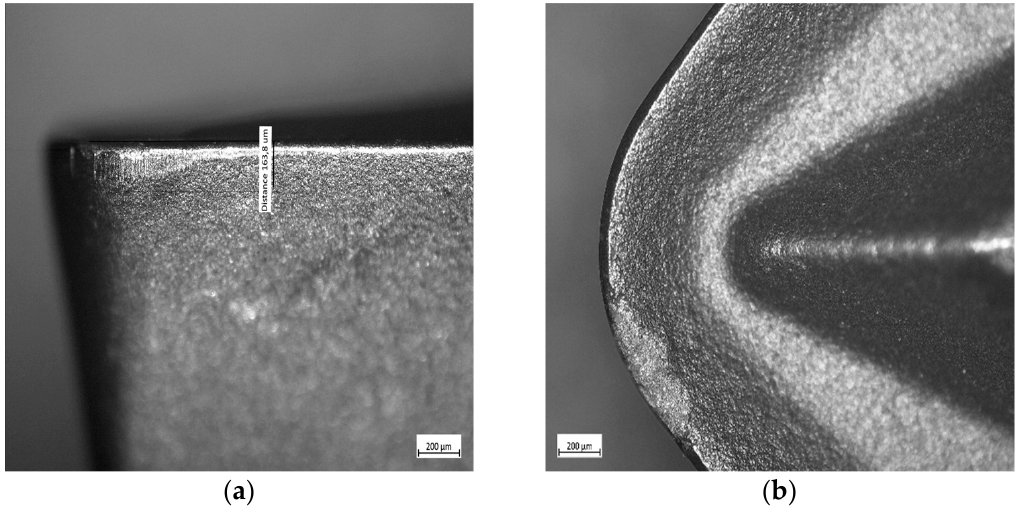
Figure 9. ( a ) Cutting insert wear, VB B —flank wear 163.8 µm; ( b ) another view from face part of the damage on cutting insert.